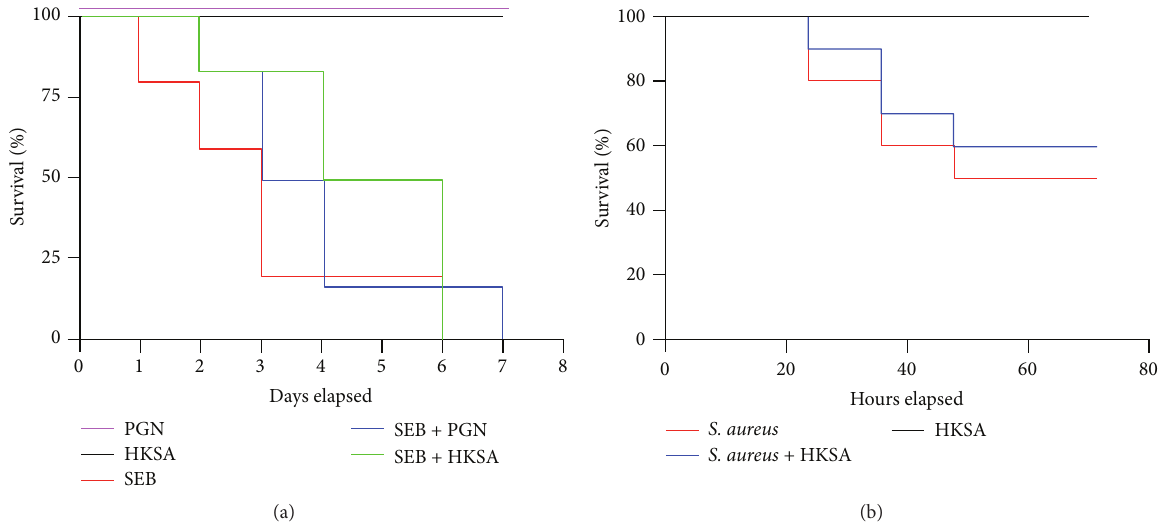
Figure 6: Effect of S. aureus -derived PAMPs on SEB-induced TSS and S. aureus -induced pneumonia. (a) HLA-DR3 transgenic mice were challengedwithstaphylococcalenterotoxinB(SEB)(50 𝜇 g),staphylococcalpeptidoglycan(PGN)(50 𝜇 g),orheat-killed Staphylococcusaureus (HKSA) (10 8 bacteria), SEB with PGN or SEB with HKSA. Animals were monitored every 6 hours (4–8 mice per group). (b) HLA-DR3 transgenic mice were challenged intratracheally with a toxigenic strain of S. aureus capable of producing the SSAg, SEA, and SEB (1.3– 2.5 × 10 8 cfu/mouse). Immediately following bacterial inoculation, mice were left untreated or injected with HKSA intraperitoneally (10 8 bacteria/mouse). Animals were monitored closely for symptoms. All moribund animals were removed from the study (6–8 mice per group).